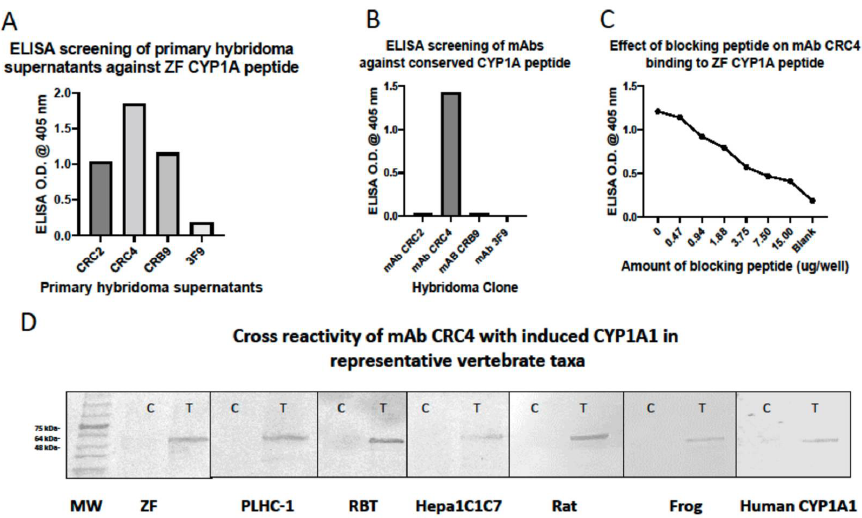
Figure 1. ( A ). ELISA results demonstrating reactivity of three primary hybridoma supernatants against zebrafish CYP1A peptide used for immunizations. ( B ). ELISA results demonstrating that only mAb CRC4 recognizes a conserved peptide sequence common to all vertebrates. ( C ). ELISA